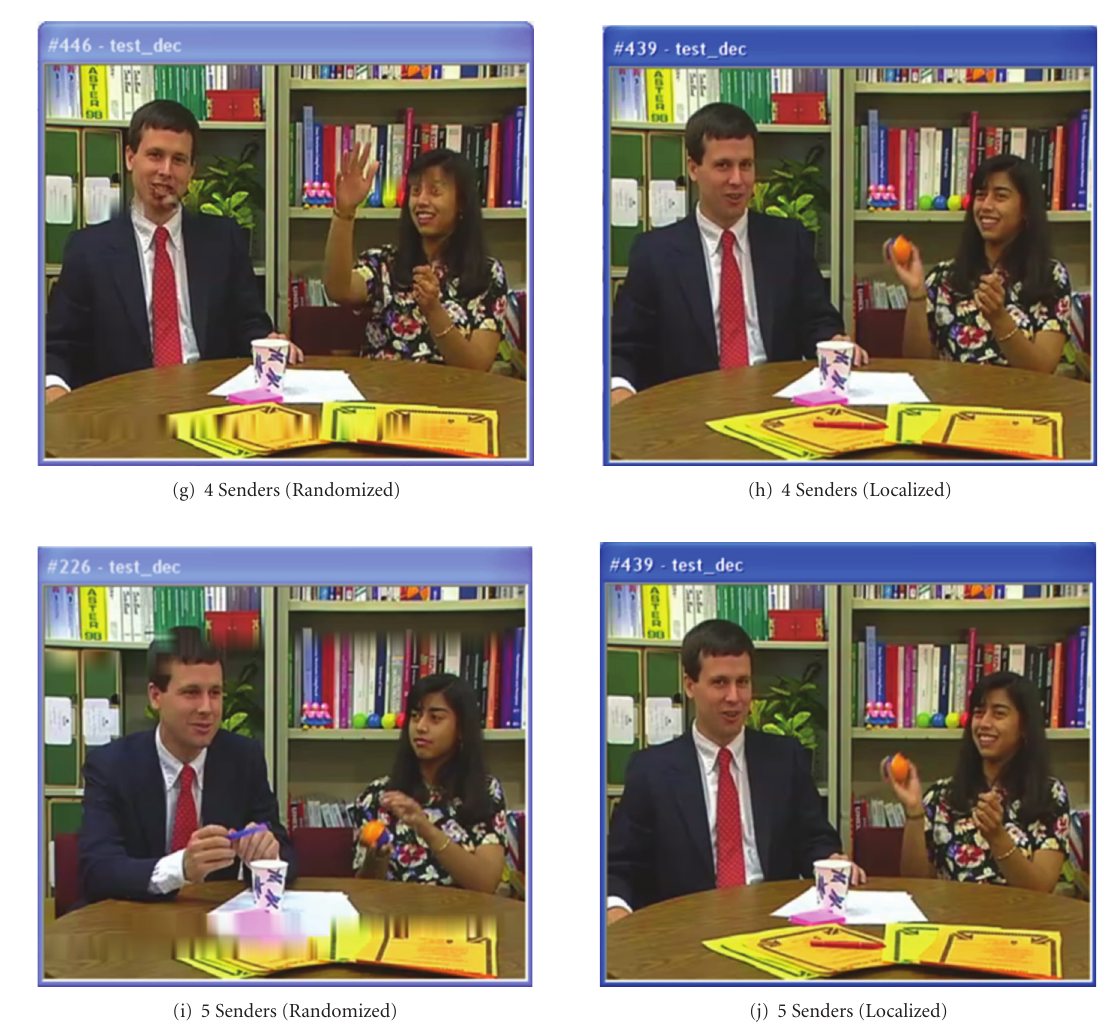
Figure 14: Subjective quality of the localized method against the randomized method for each redundancy level (S1 ... S5).